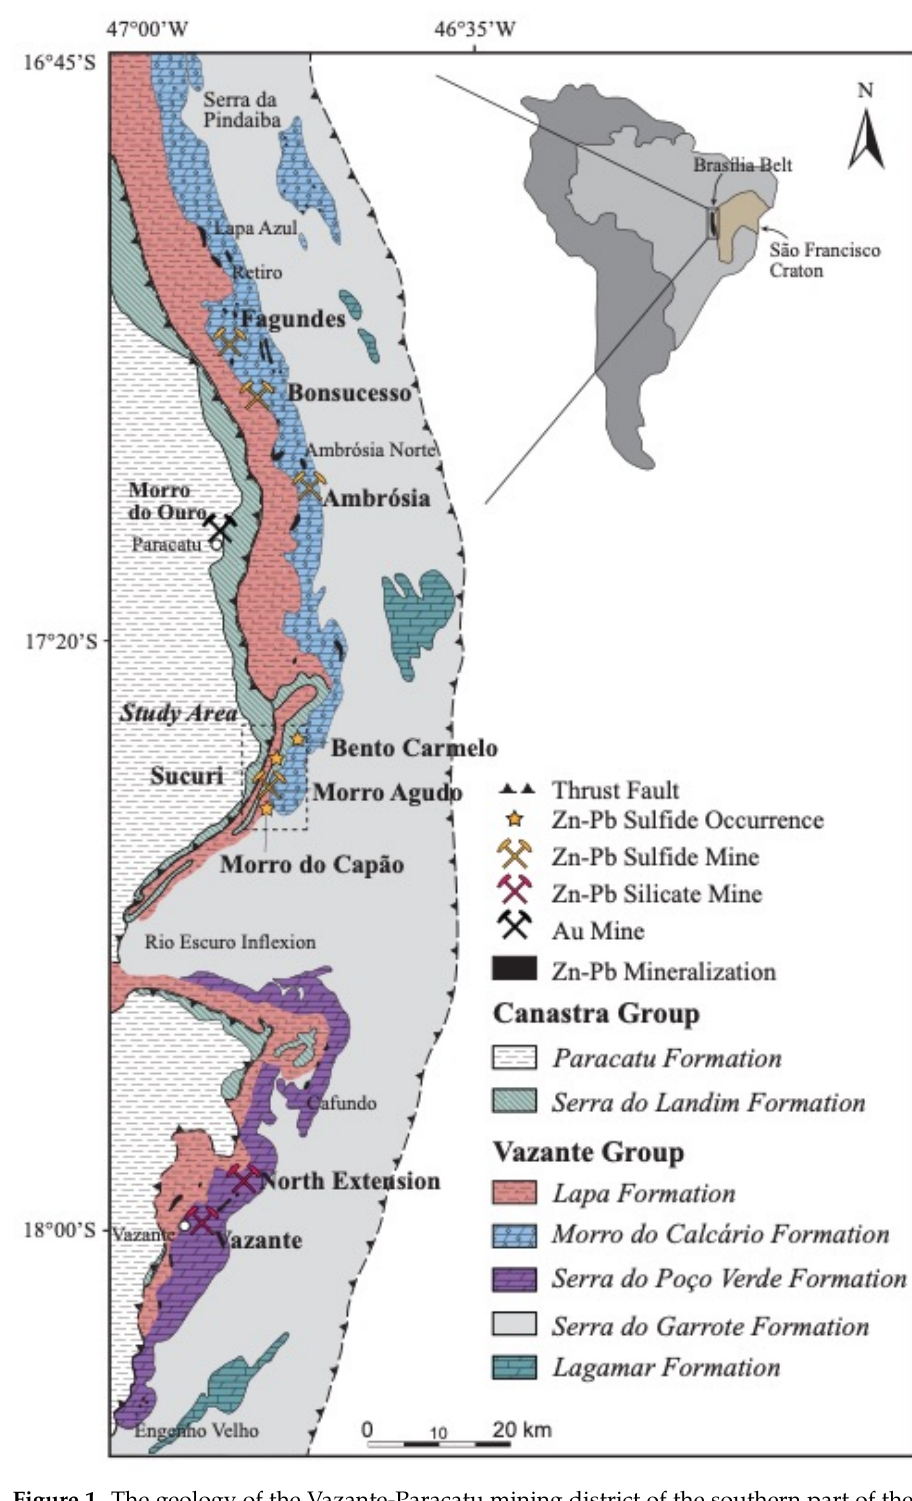
Figure 1. The geology of the Vazante-Paracatu mining district of the southern part of the Brasília Fold Belt, showing the locations of the mines and occurrences (modified from [6,11,12]), and the inset shows the relation to the Brasília Fold Belt with the São Francisco Craton. Dashed box represents the study area (Figure 3).